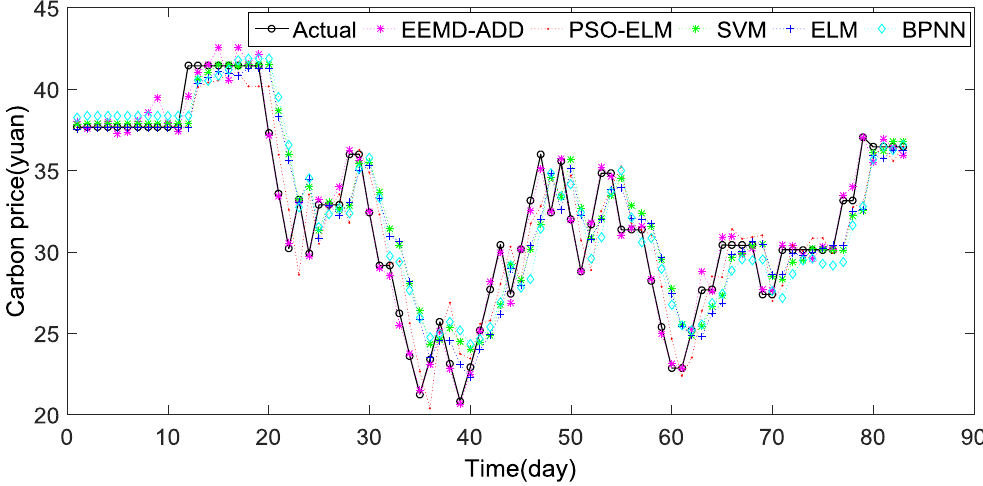
Figure 7. The results of the carbon price sequence predictions of the five models. Table 8. The statistical values of the carbon price predictions of the five models.